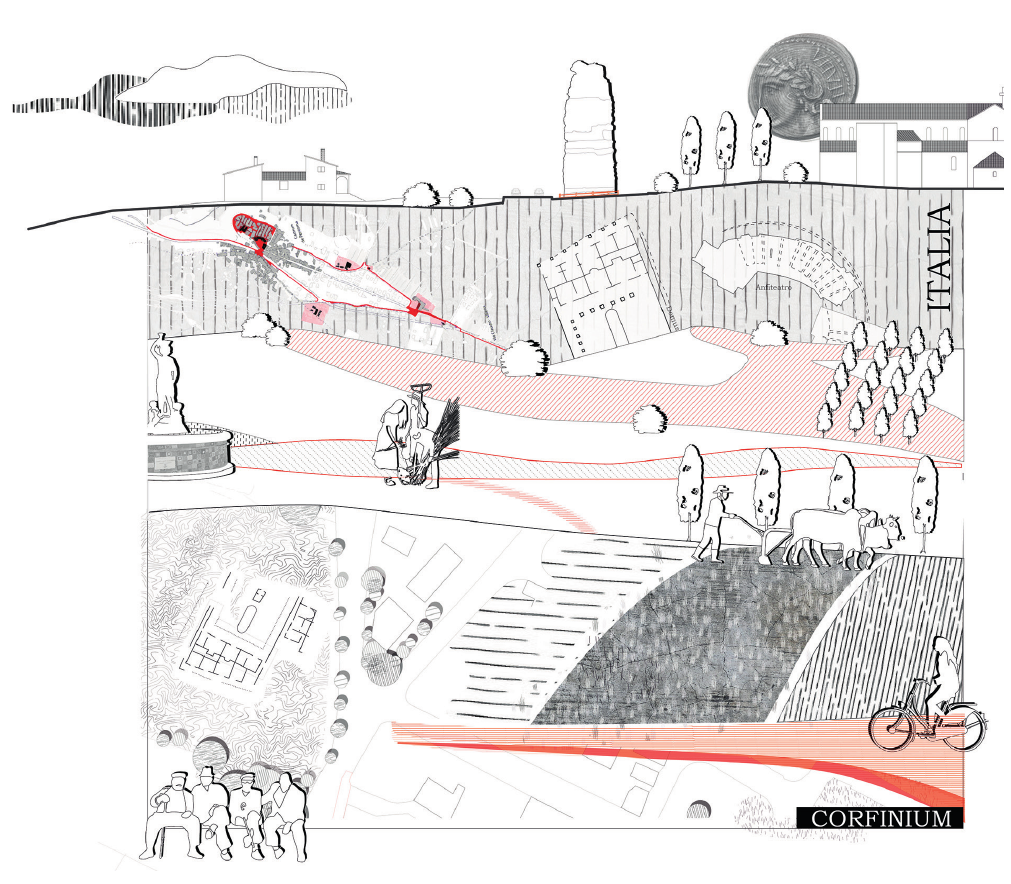
Fig. 4 Elaboration by the reinterpretation of these two elements: urban layout authors, Visualize a possible and territorial layout, combined with a series of activities design interaction , 2021, Digital and initiatives carried out by the local community and drawing, 16x14, Elaboration Cooperative. from the dynamic atlas. The visualization synthesizes the These were first surveyed and reconnected at the spatial and community network various scales, thus identifying a recomposition strategy. that could interact with a The urban and territorial cornerstones were then reactivation project for the linked to the plots, drawing a framework to place the actions of physical, visual, and perceptive transformation, linking them to the actions underway by identifying and mapping urban and territorial functions.